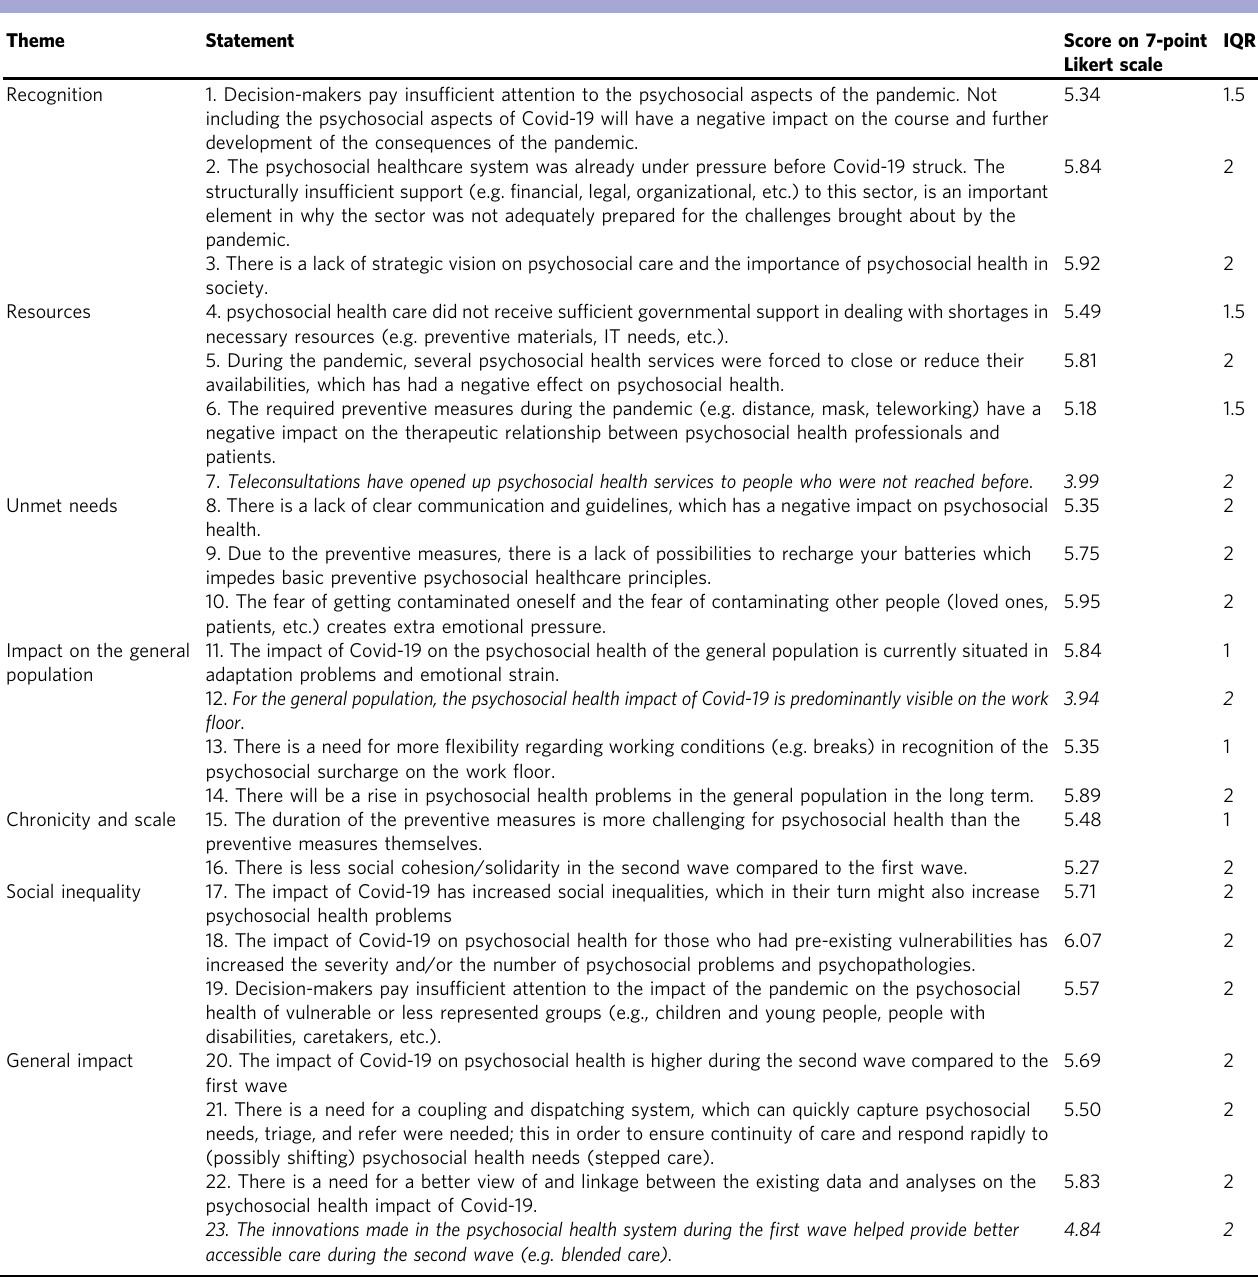
Table 3 Summary of consensus on 23 statements in round 2 indicating the three statements for which no robust consensus is indicated in